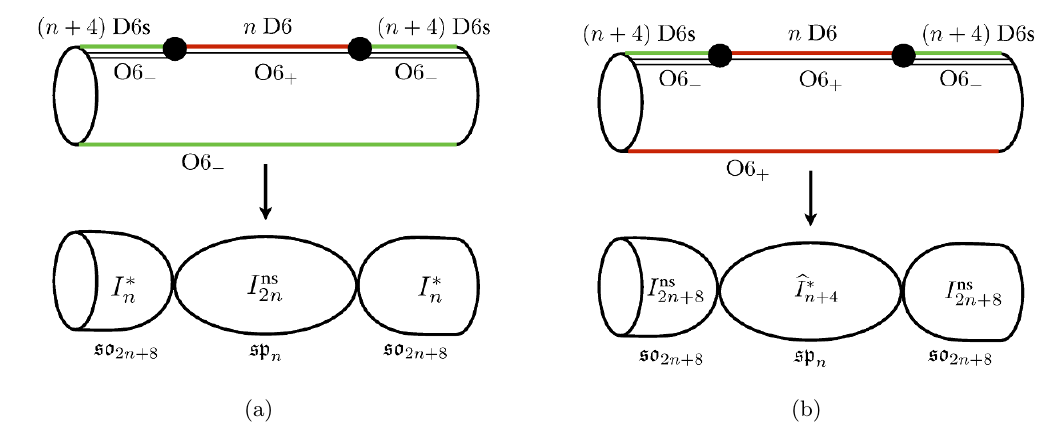
Figure 5 . Two con(cid:12)gurations with O7